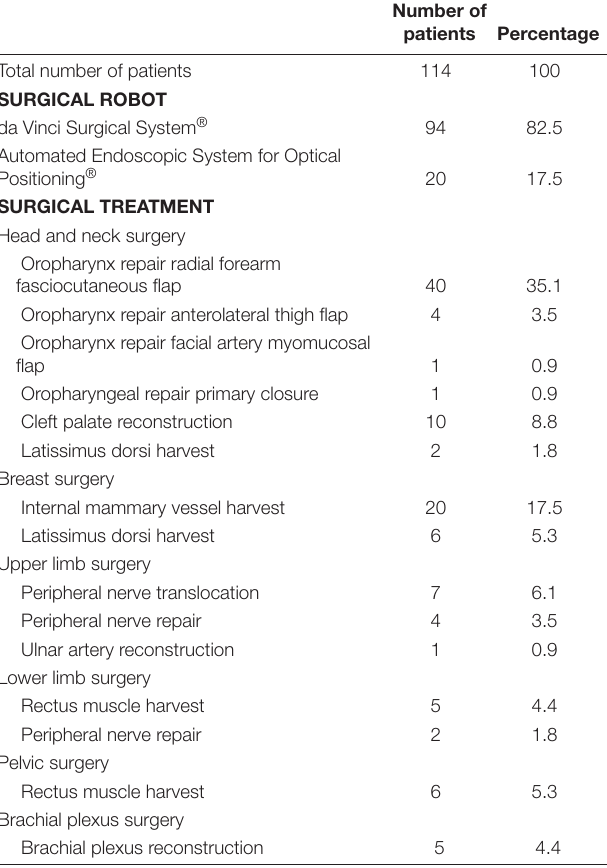
tabLe 2 | Surgical robotics and interventions in